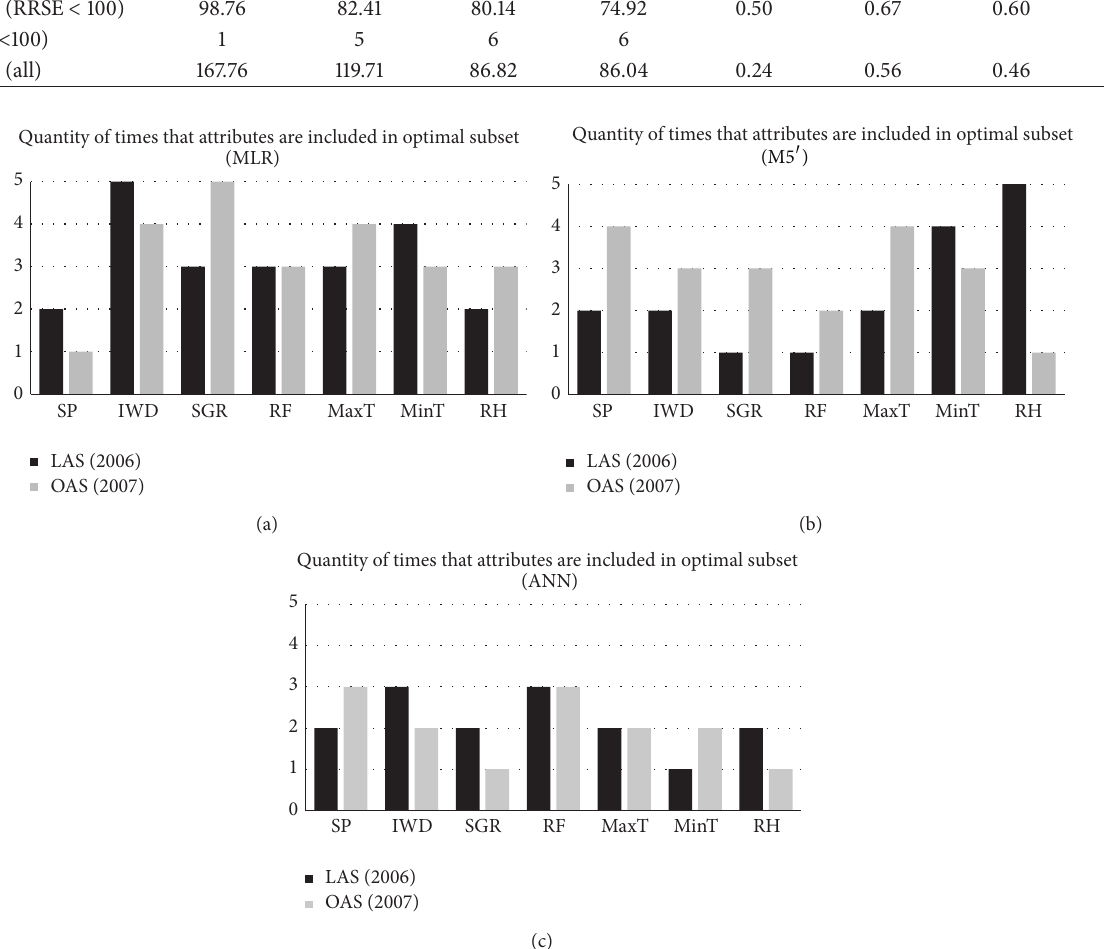
data (CBP02, CBA03, CBM04, PA06, and PA07). Figures